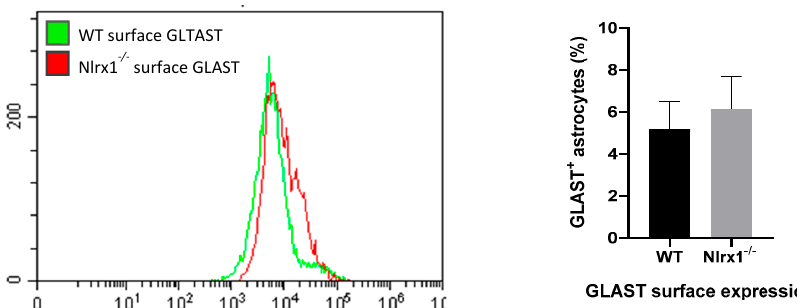
Figure 4. mRNA and protein expression of GLT-1 and GLAST in astrocytes. ( A ) mRNA expression of GLT-1 and GLAST is significantly upregulated in Nlrx1 -/- astrocytes compared to WT ( n = 5). ** p < 0.01 as determined by Mann–Whitney test; ( B ) the total protein expression of GLT-1 and GLAST proteins in WT and Nlrx1 -/- astrocytes was measured by flow cytometry ( n = 5); ( C ) the cell surface expression of both transporters on astrocytes was measured by flow cytometry ( n = 7). Representative flow cytometric histograms presented on the left side, p > 0.05 as determined by Mann–Whitney test, results are presented as mean ± SEM.